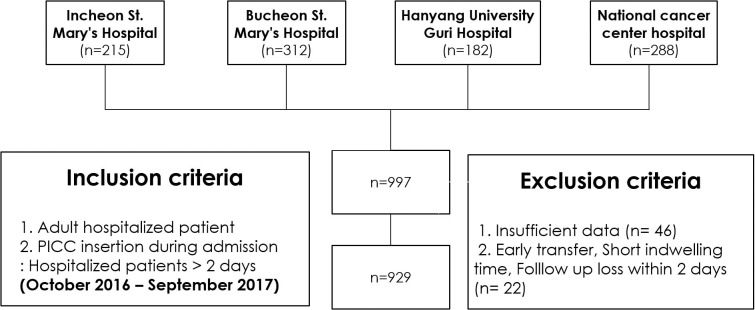
Study enrollment.